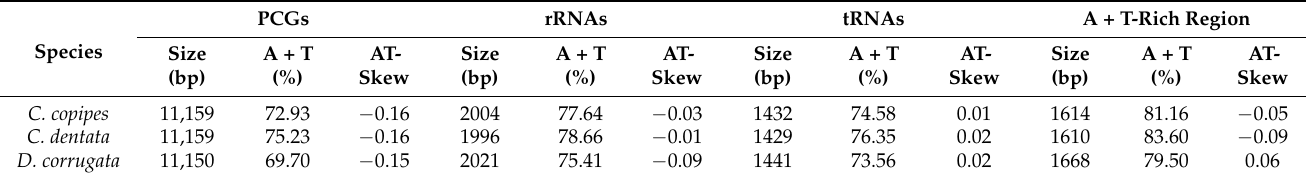
Table 3. Summarized mitogenomic characteristics of the three buprestid species investigated in this